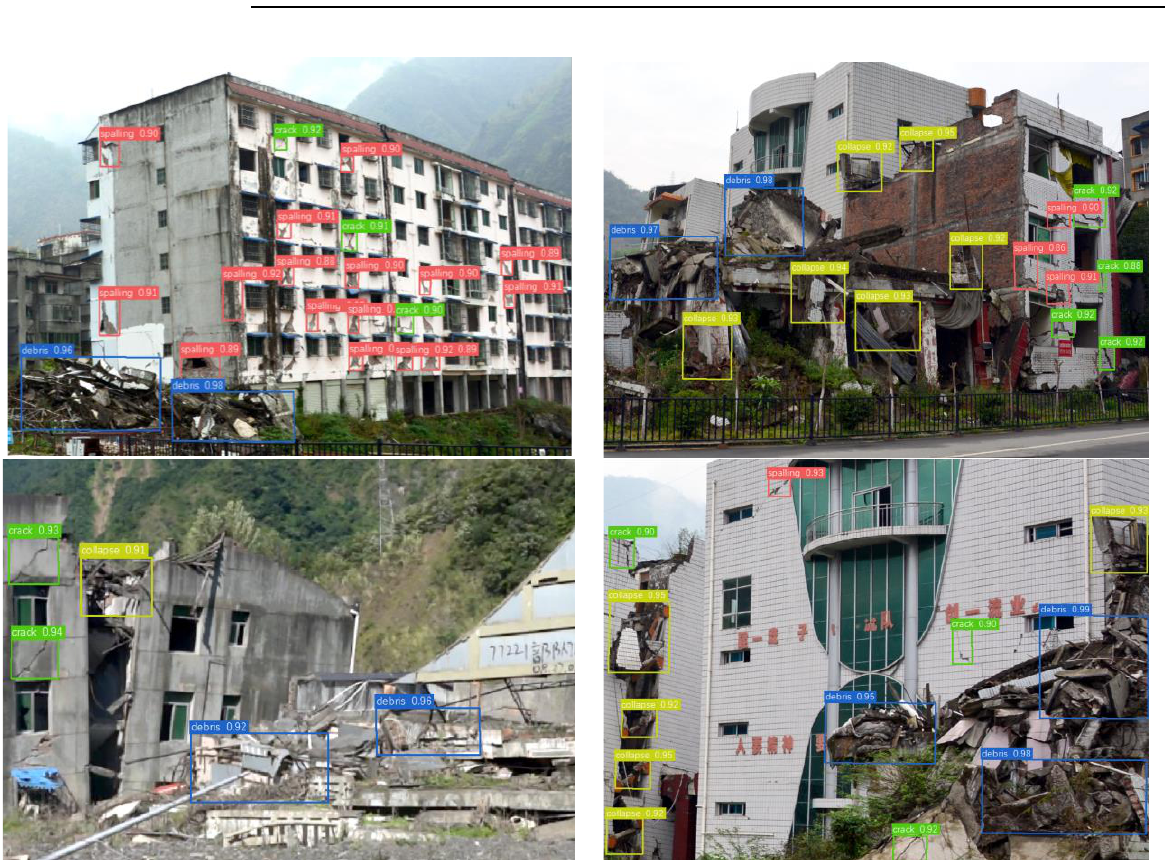
Figure 10. Different damage recognition in GDBDA dataset. Multi-class target detection results for images at near and far distances, where different colors represent different targets. (Note: The Chinese term in each image refers to the sign or slogan on the building's exterior).